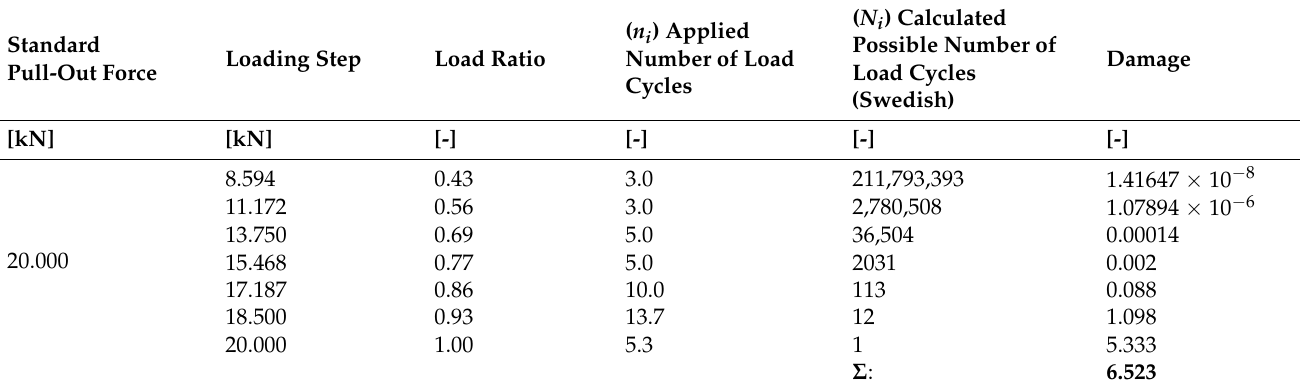
Table 6. Values of damage at different load levels (based on linear damage